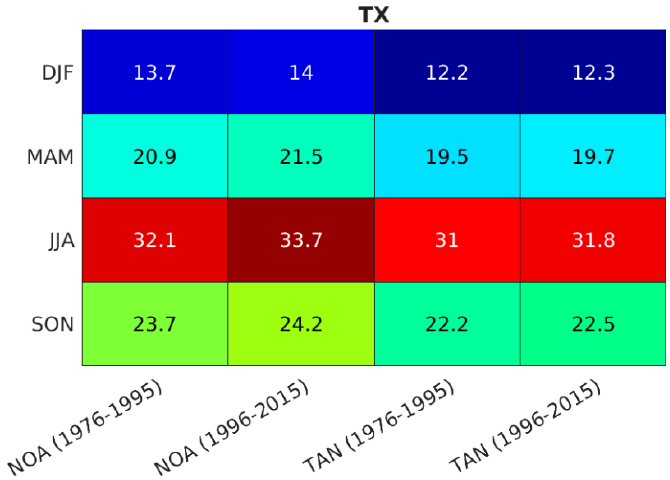
Figure 2. Seasonally averaged maximum temperatures (T max ) for the two reference periods (1976–1995 and 1996–2015) at the meteorological stations of NOA (urban) and TAN (rural). Bootstrap analyses show that only summer (JJA) T max values are statistically significantly different between the reference periods at the respective stations. Abbreviations: winter (DJF), spring (MAM), summer (JJA), autumn (SON).